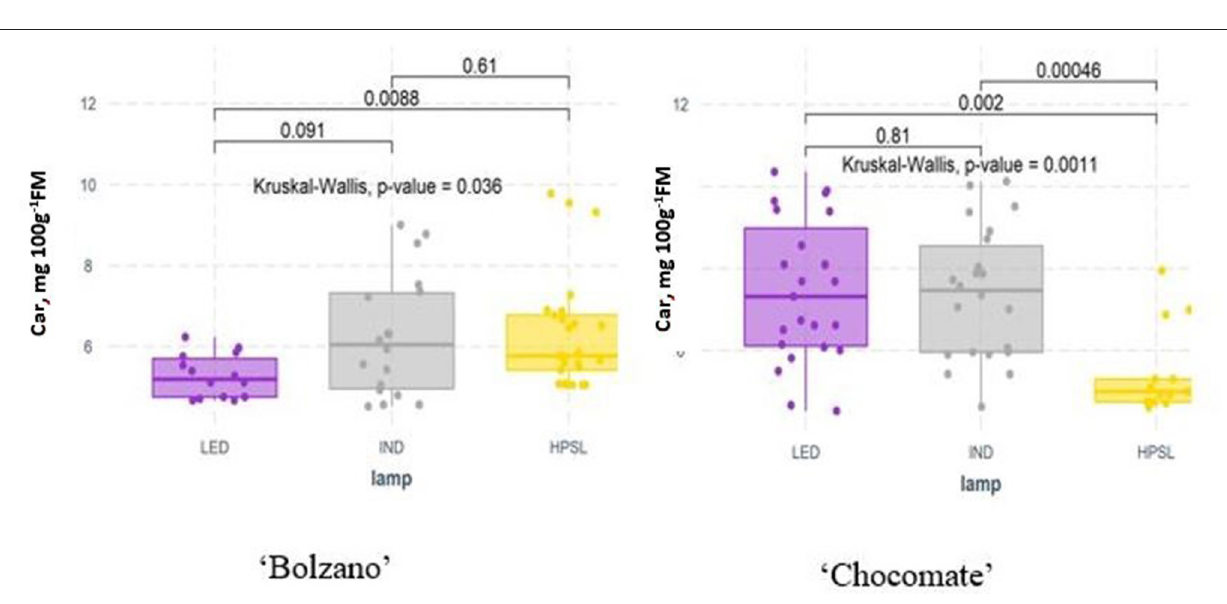
TABLE 2 | Content of total phenolics [mg gallic acid equivalent (GAE) 100 g − 1 FM] and flavonoids [mg citric acid (CA) 100 g − 1 FM] in the tomato fruits grown under different supplemental lighting. Parameter “Bolzano” “Chocomate” “Encore” “Diamont” “Strabena” Phenols